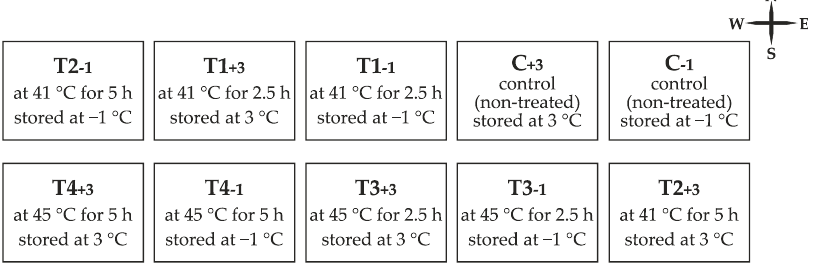
Figure 2. Block distribution of Quercus robur acorn groups exposed to different thermotherapy treatment and storage conditions sown in the nursery trial.